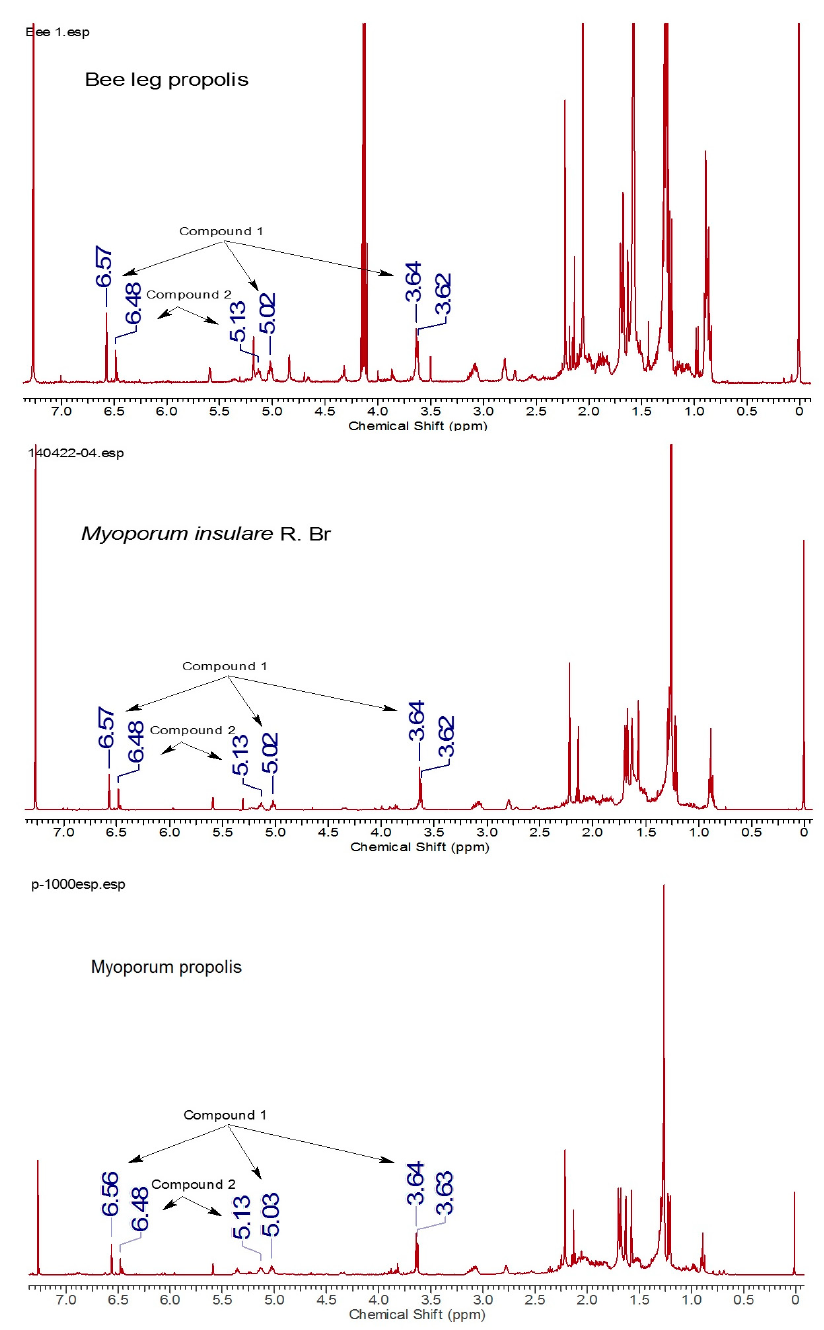
Figure 4. 1 H-NMR spectra for bee leg propolis, plant resin and myoporum propolis.